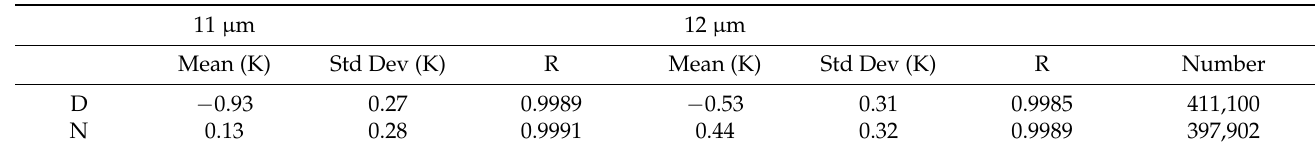
Figure 3. The relationship between VIRR and MODIS simulated BT: ( a ) 11 μ m in the daytime; ( b ) 12 μ m in the daytime; ( c ) 11 μ m in the nighttime; ( d ) 12 μ m in the nighttime. Table 3. The Double Difference between VIRR_BT and MODIS_BT (D means daytime, N means nighttime, R means correlation coefficient).